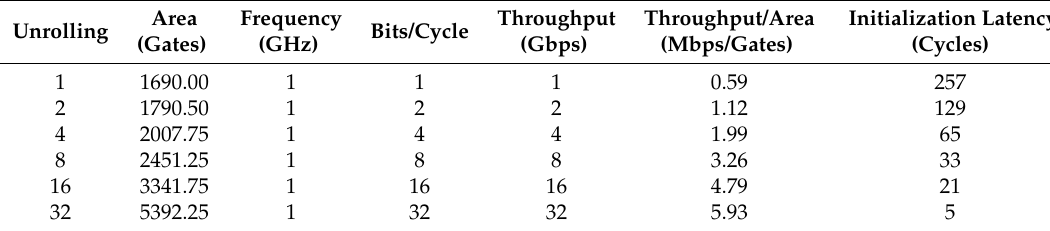
Table 7. Grain-128 synthesis results (65 nm).